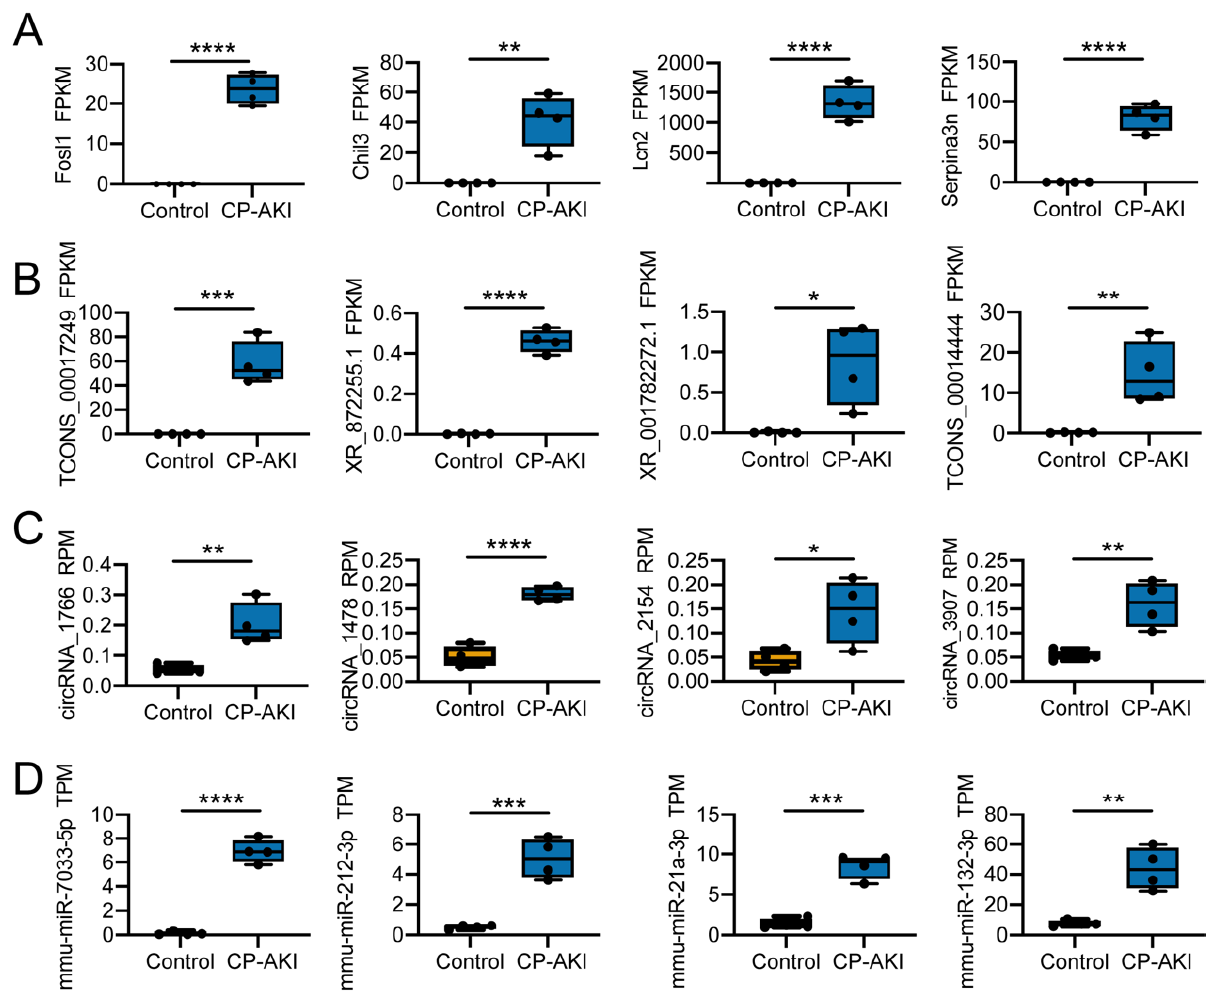
Figure 3. Upregulated mRNA and non-coding RNA (ncRNA) expression levels: the CP-AKI model versus the control group. ( A ) Differential expression analysis of mRNAs, quantified as fragments per kilobase of exons per million fragments mapped (FPKM). ( B ) Differential expression analysis of long non-coding RNAs (lncRNAs), quantified as FPKM. ( C ) Differential expression analysis of circular RNAs (circRNAs), quantified as reads per million (RPM). ( D ) Differential expression analysis of microRNAs (miRNAs), quantified as transcripts per million (TPM). n = 4. * p < 0.05, ** p < 0.01, *** p < 0.001, **** p <